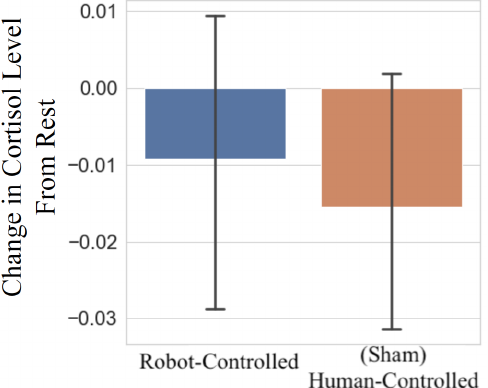
Figure 6. Two-sample t-test indicated that participants showed a non-significant change in salivary cortisol during their (sham) human-controlled and robot-controlled